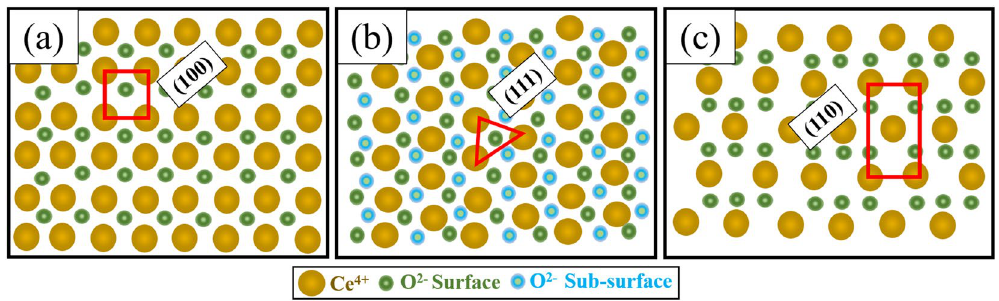
Figure 7. Representation of 2D confinement of (100), (111) and (110) planes of CeO 2 in cubic fluorite crystal